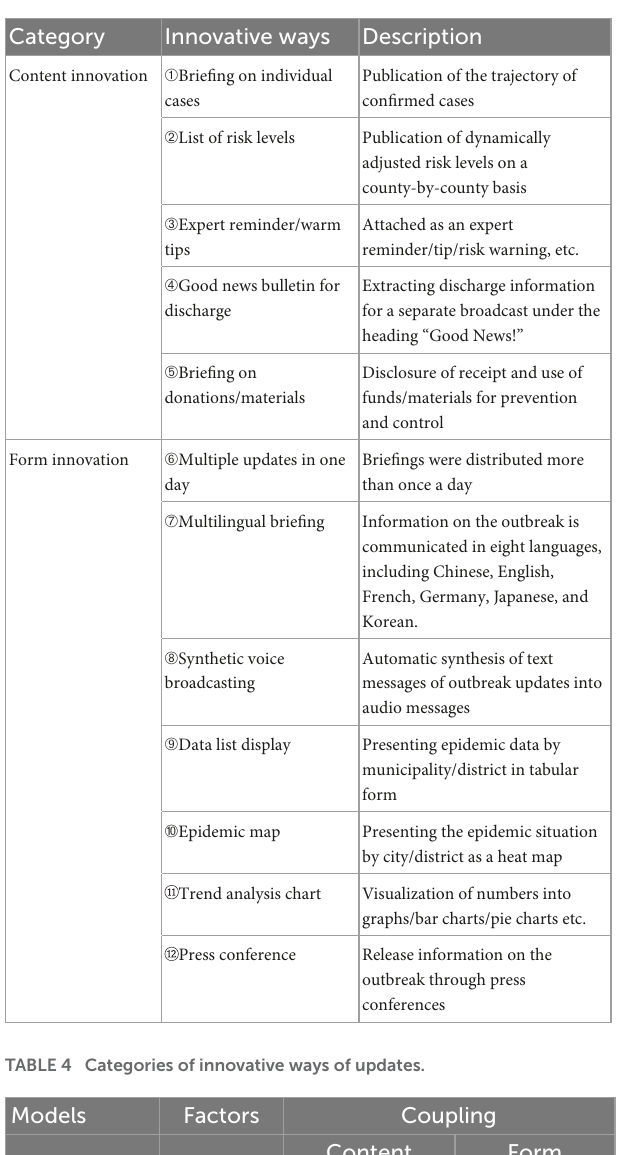
TABLE 3 Categories of innovative ways of updates.